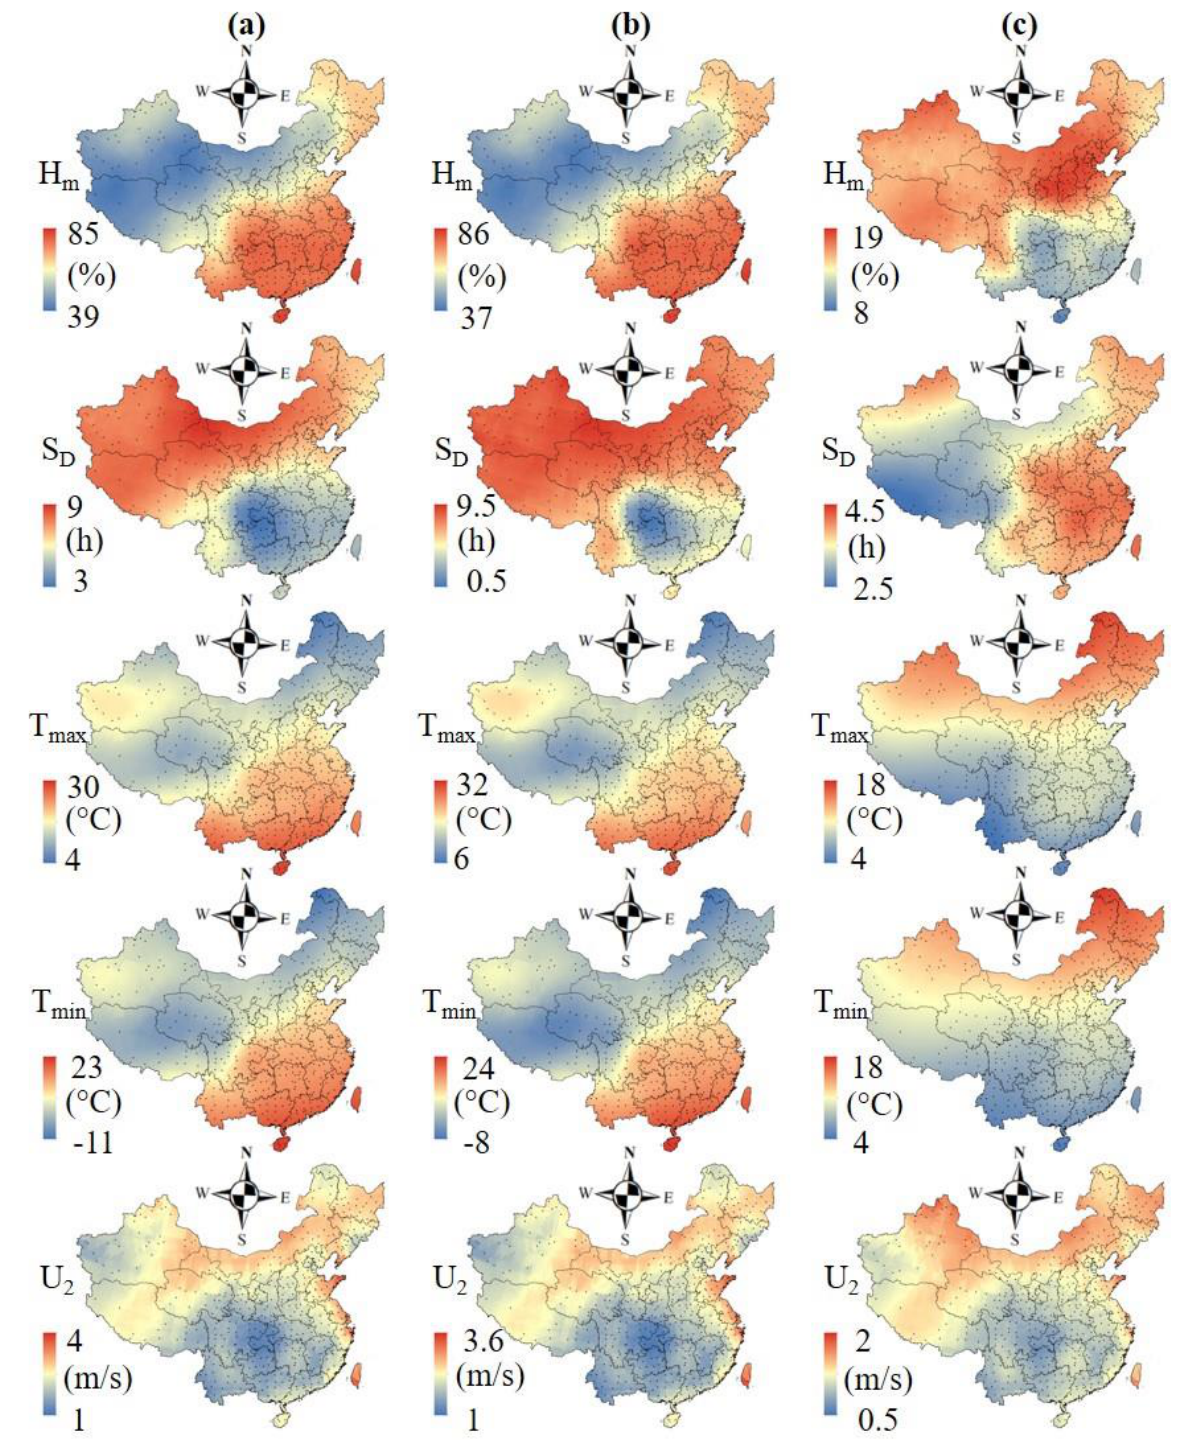
Figure 4. Descriptive statistics of the daily climatic variables: ( a ) mean; ( b ) median; and ( c ) standard deviation.